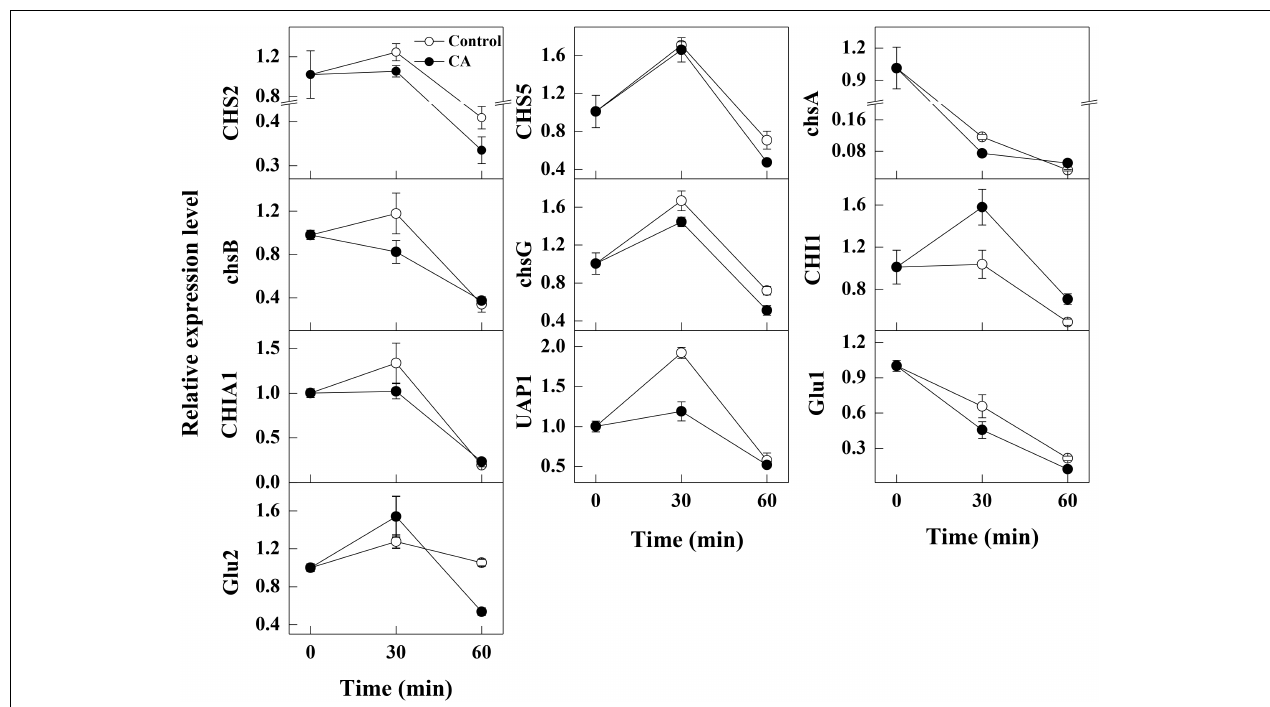
FIGURE 5 | Changes in the expression levels of the cell wall integrity related genes in control and 1/2MIC CA treated G. citri-aurantii mycelia. The data presented are the means of pooled data. Error bars indicate the SDs of the means ( n =